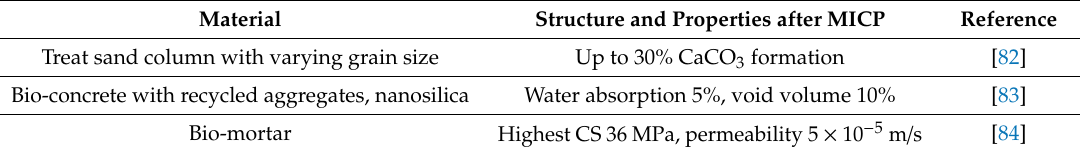
Table 4. Materials produced using MICP with Bacillus